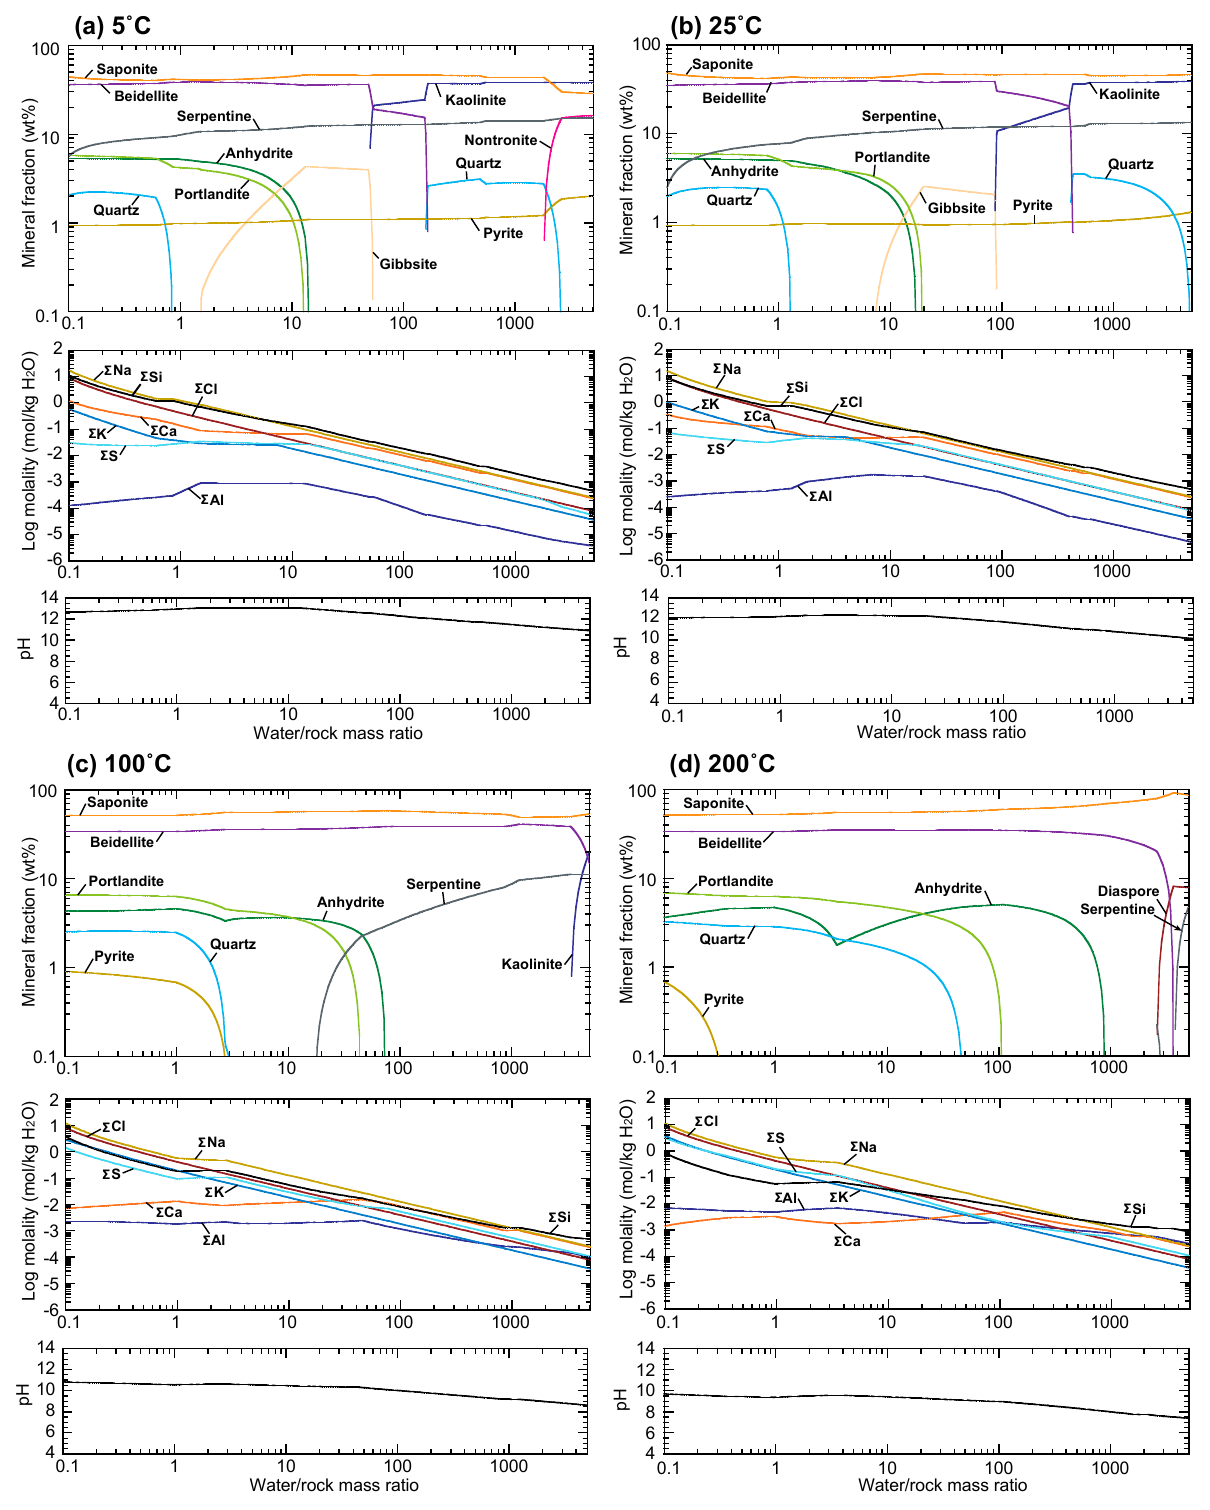
Figure 4. Results of the modeled secondary mineral assemblage, dissolved ion concentration in groundwater, and pH when Mars rock reacted with gas-free initial fluid (Case III-DG) at ( a ) 5 °C; ( b ) 25 °C; ( c ) 100 °C; and ( d ) 200 °C.